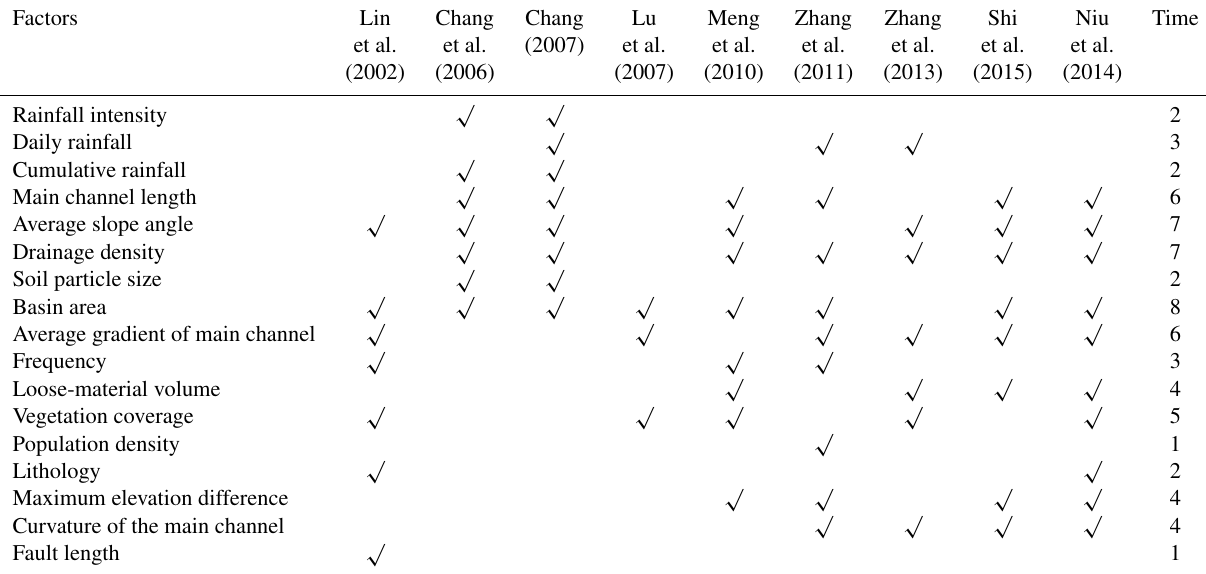
Table 3. Factors frequently used in susceptibility analysis of debris flow.